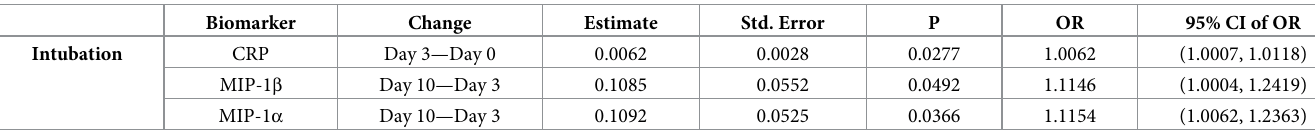
Table 7. Statistical Correlation to Progression of Track 2 to